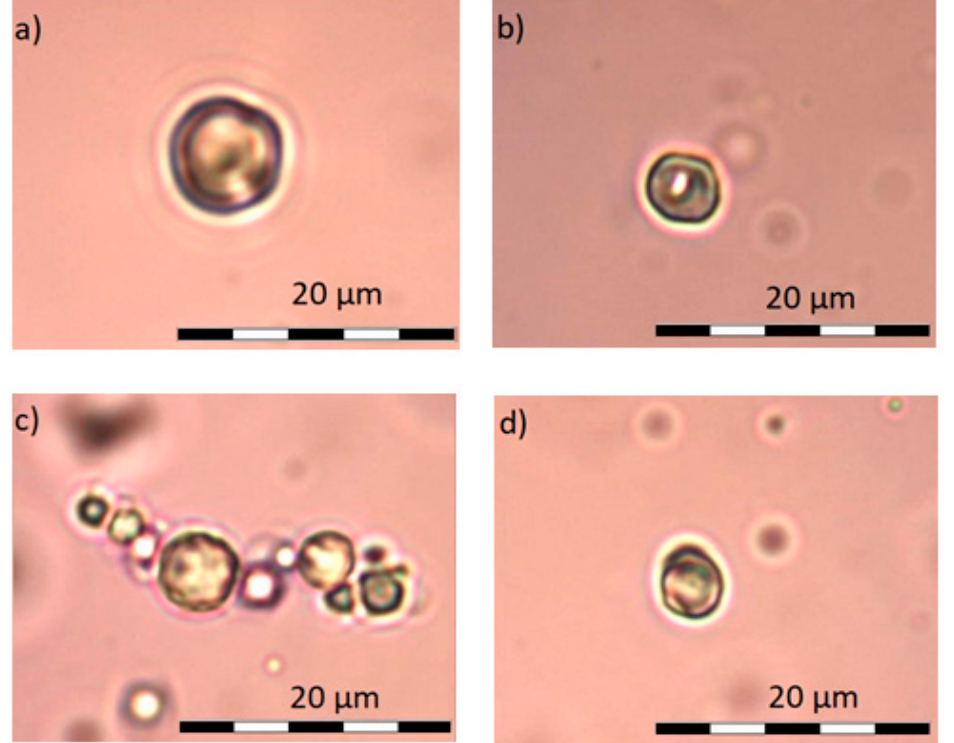
Figure 4. Undissolved crystal of calcium dobesilate.